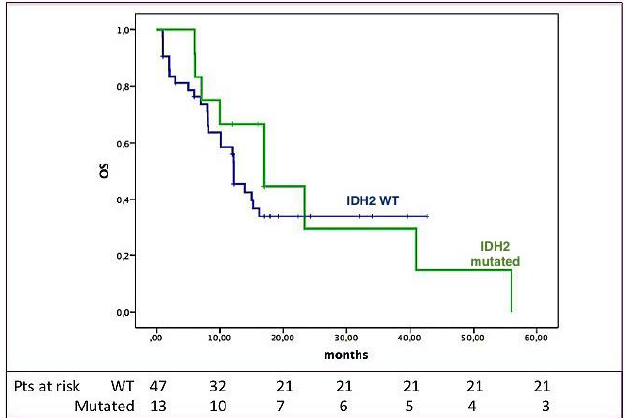
Figure 1. IDH2 mutational status and overall survival (OS). OS according to the presence/absence of IDH2 mutations; as shown, OS was not different between IDH2-unmutated (blue) and -mutated (green) patients.